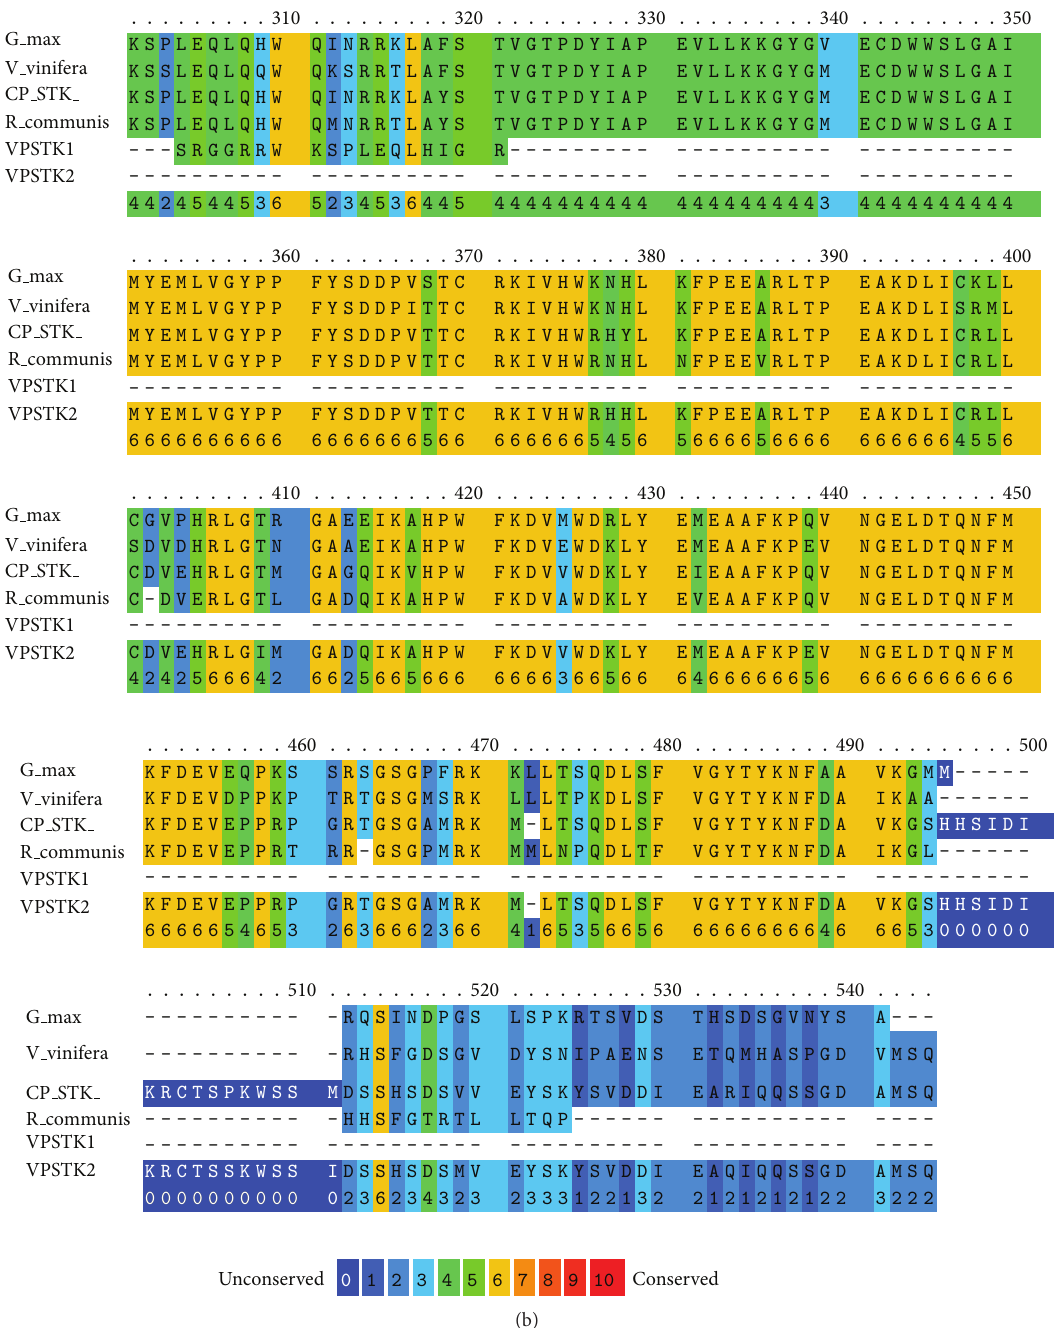
Figure 1: Alignment of deduced amino acid sequences of CP STK, VP STK1, and VP STK2 with the sequences of STK Ricinus communis (XP002514097), Glycine max (XP003547484), and Vitis vinifera (XP002279199). Unconserved to conserved region is coloured in scale from 0 to 10 and shown on the last line in each